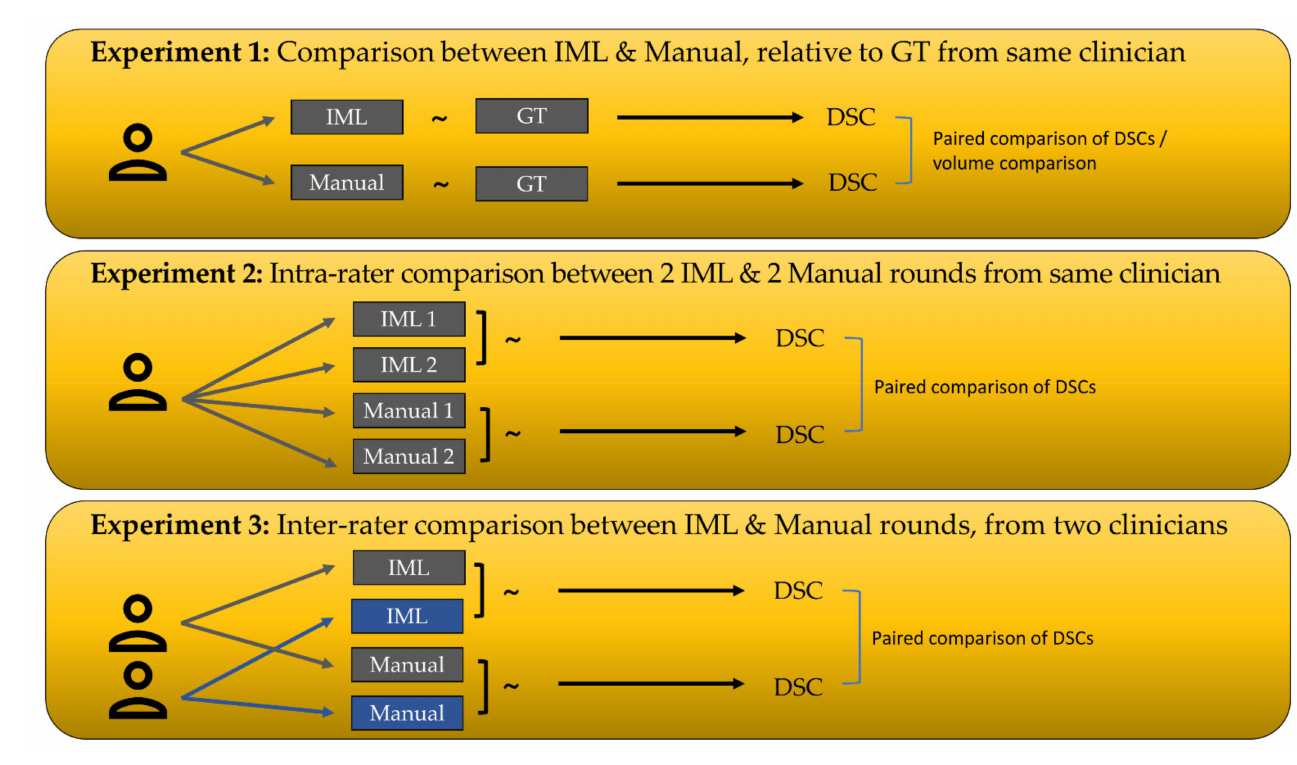
Figure 3. Summary of the main experimental design. The “~” symbol denotes calculation of Dice coefficient between two segmentations. DSC = Dice Similarity Coefficient, GT = Ground